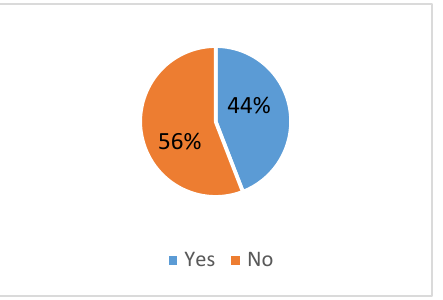
Figure 3. The proportion of farmers using one or more FMIS.